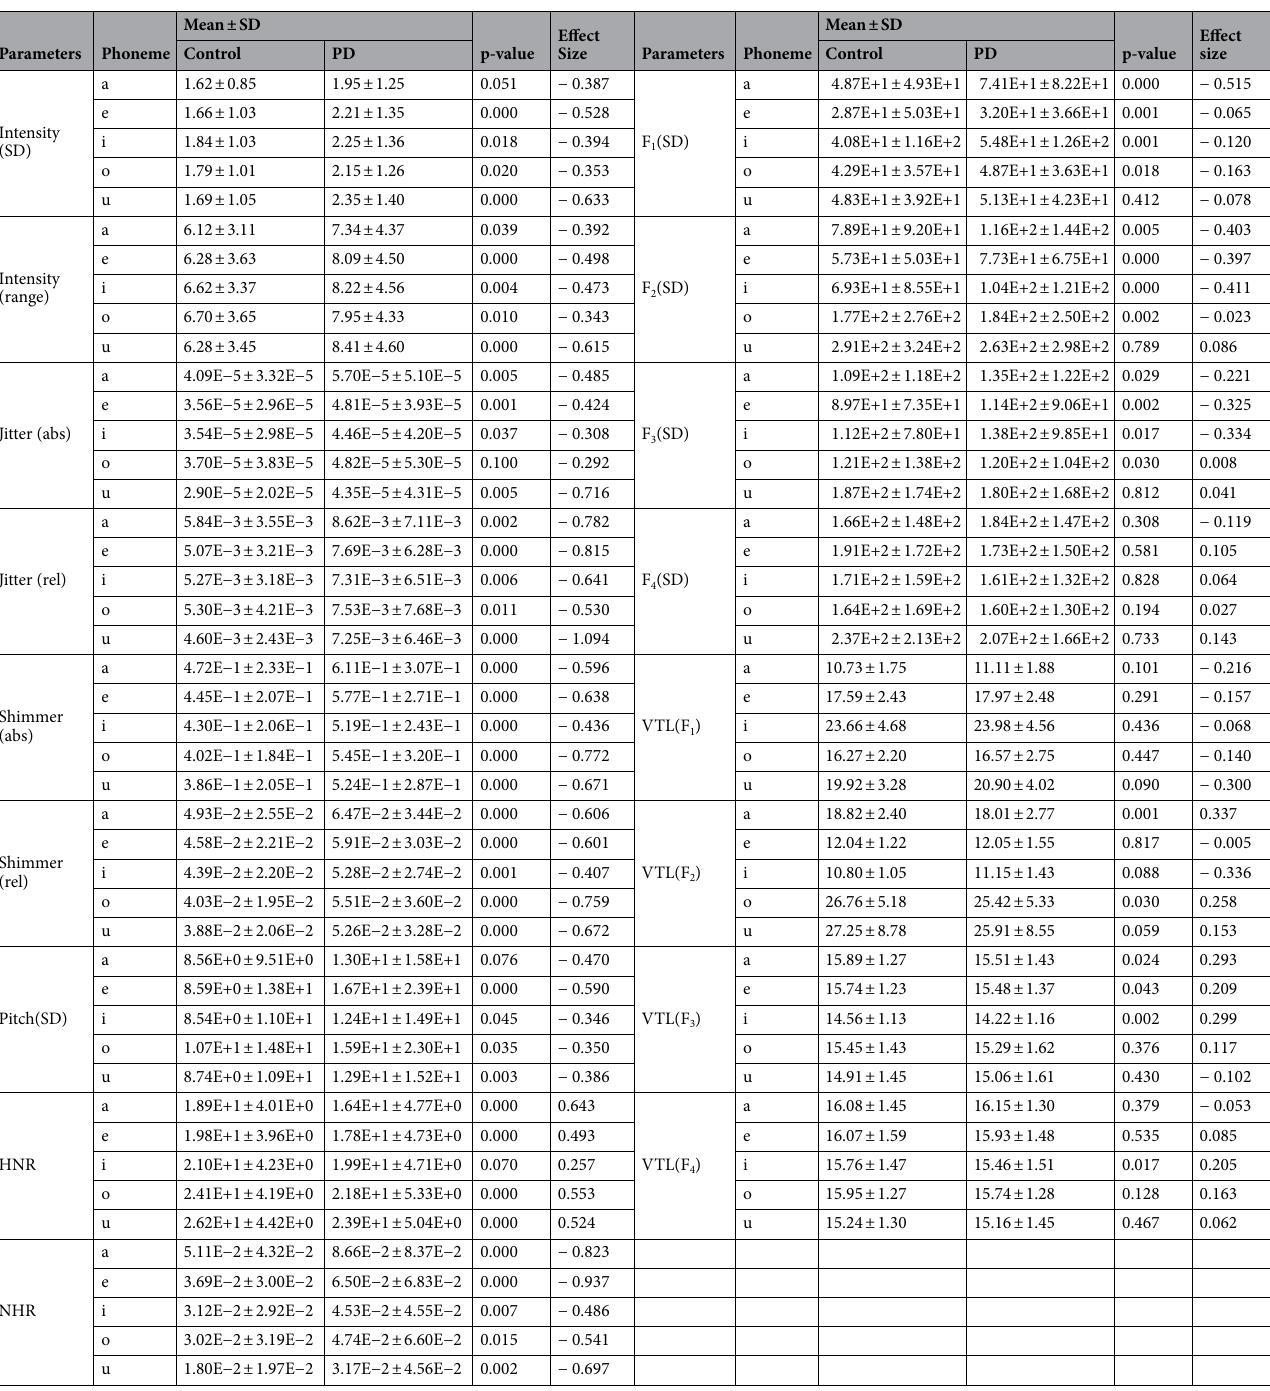
Table 3. Statistical distribution and the result of Mann Whitney